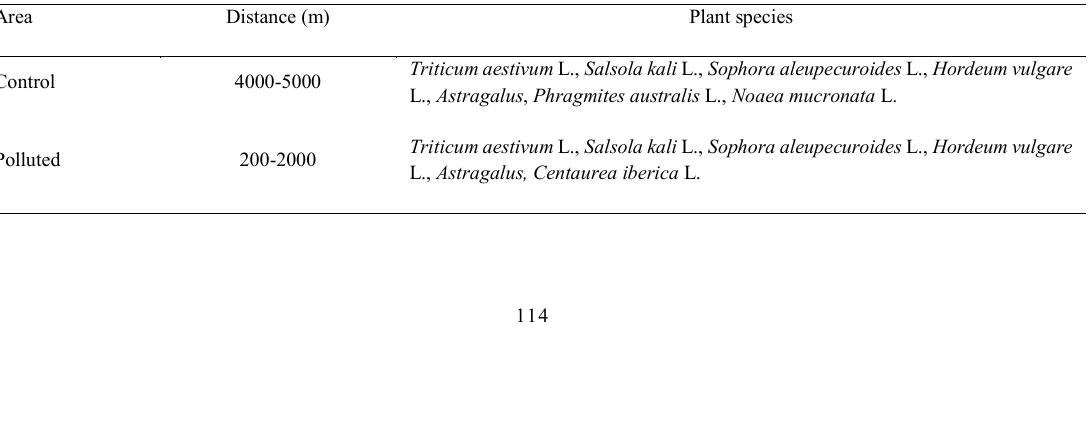
Table 1: Properties of plant species around the cement factory of Kurdistan